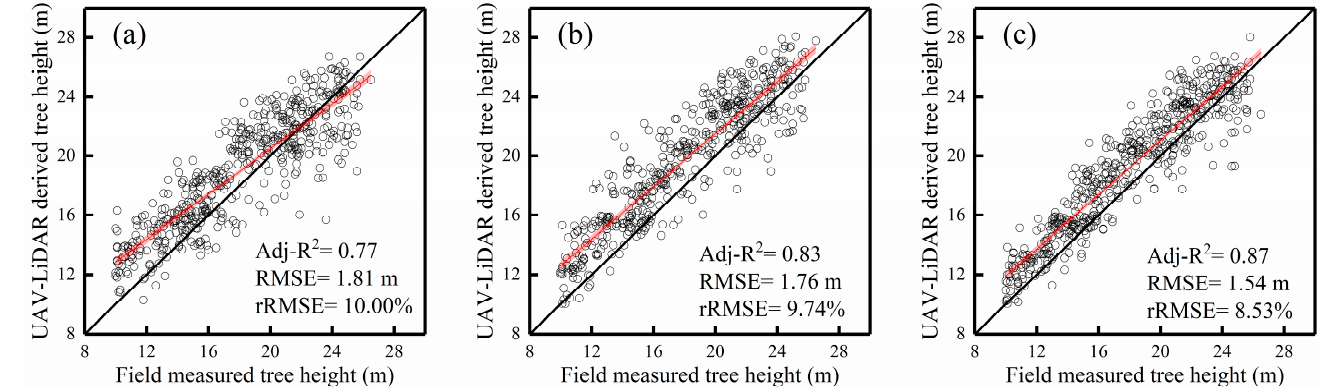
Figure 5. Comparison of the field-measured tree heights (tree height ≥ 10 m) and estimated individual tree heights from leaf-off dataset (507 trees). ( a ), leaf-on dataset (481 trees) ( b ), and the fused dataset (537 trees) ( c ). Black and red solid lines are the 1:1 and regression lines, respectively.